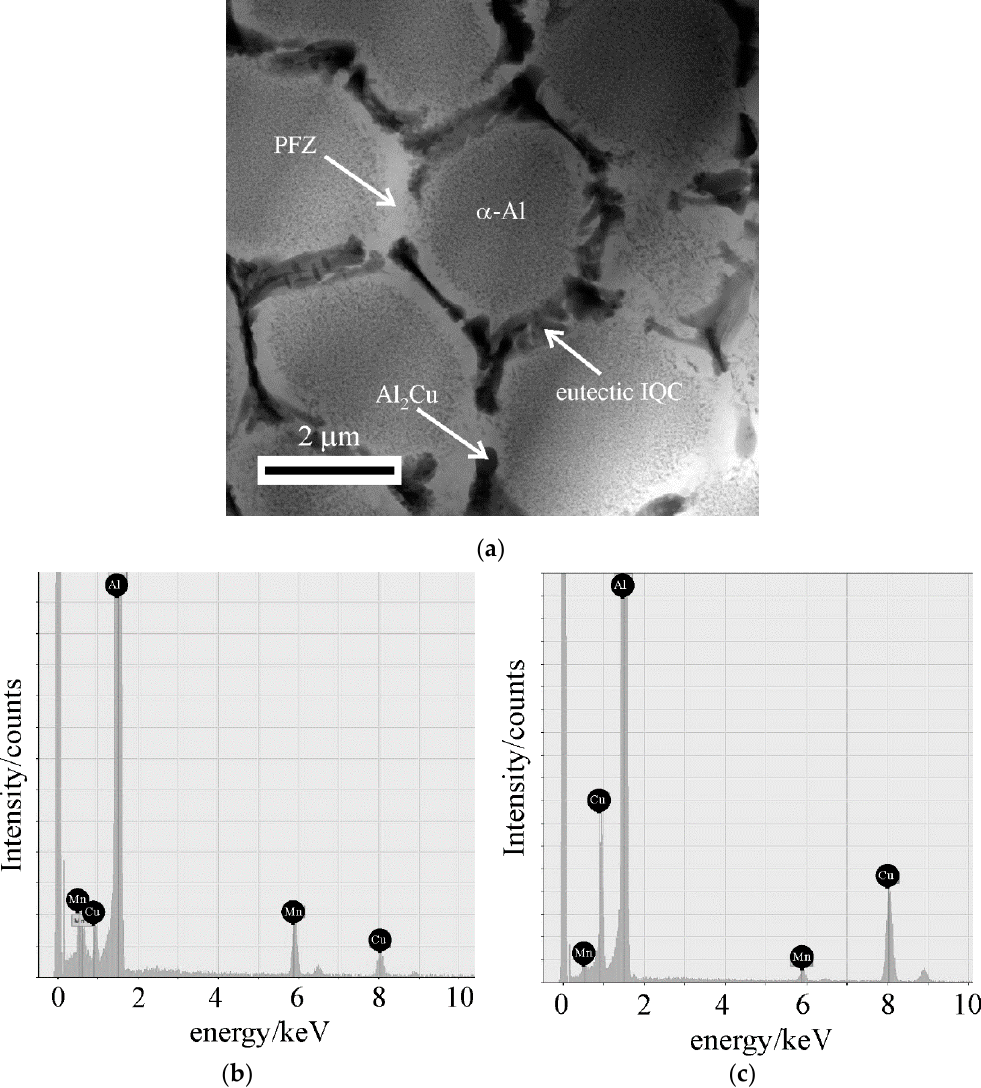
Figure 5. ( a ) Bright field transmission electron micrograph of the alloy Al 95.4 Mn 1.8 Cu 1.6 Be 1.2 after ageing at 400 °C for 1 h; sample diameter 4 mm (PFZ—precipitation free zone). ( b ) EDS spectrum of the eutectic IQC and ( c ) of Θ -Al 2 Cu.